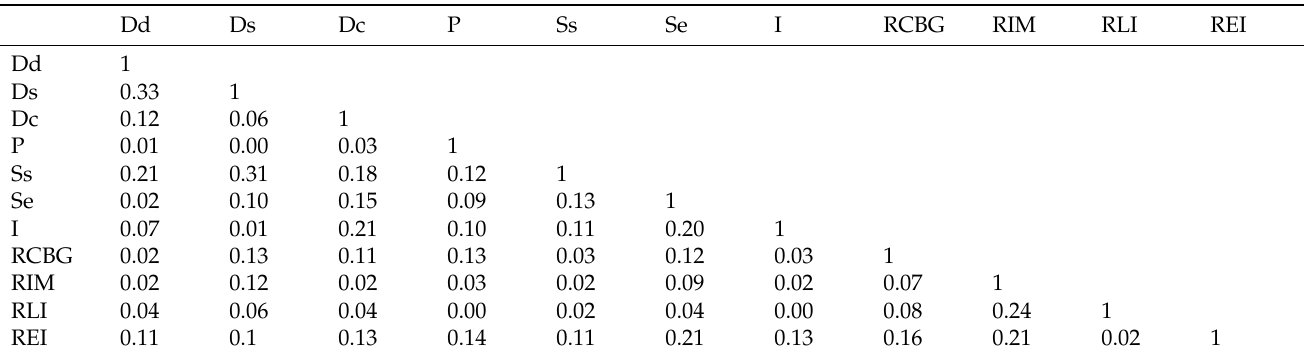
Table 1. Correlation matrix of variables.